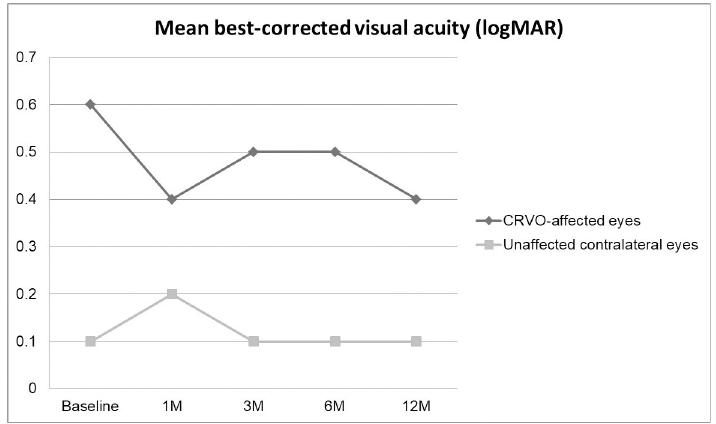
Fig 1. Changes of mean best-corrected visual acuity (BCVA) in central retinal vein occlusion (CRVO)-affected eyes and unaffected contralateral eyes over 12 months. The mean BCVA at each follow-up point was significantly worse in the CRVO-affected eyes than those in the unaffected contralateral eyes ((P < 0.001 at baseline; P = 0.013 at 1 month; P = 0.008 at 3 months; P = 0.002 at 6 months; and P = 0.001 at 12 months). https://doi.org/10.1371/journal.pone.0255182.g001 between CRVO-affected eyes and contralateral eyes at any follow-up time point (P = 0.782 at baseline; P = 0.815 at 1 month; P = 0.872 at 3 months; P = 0.715 at 6 months; and P = 0.609 at 12 months). Changes in mean SFCT are shown in Fig 3.